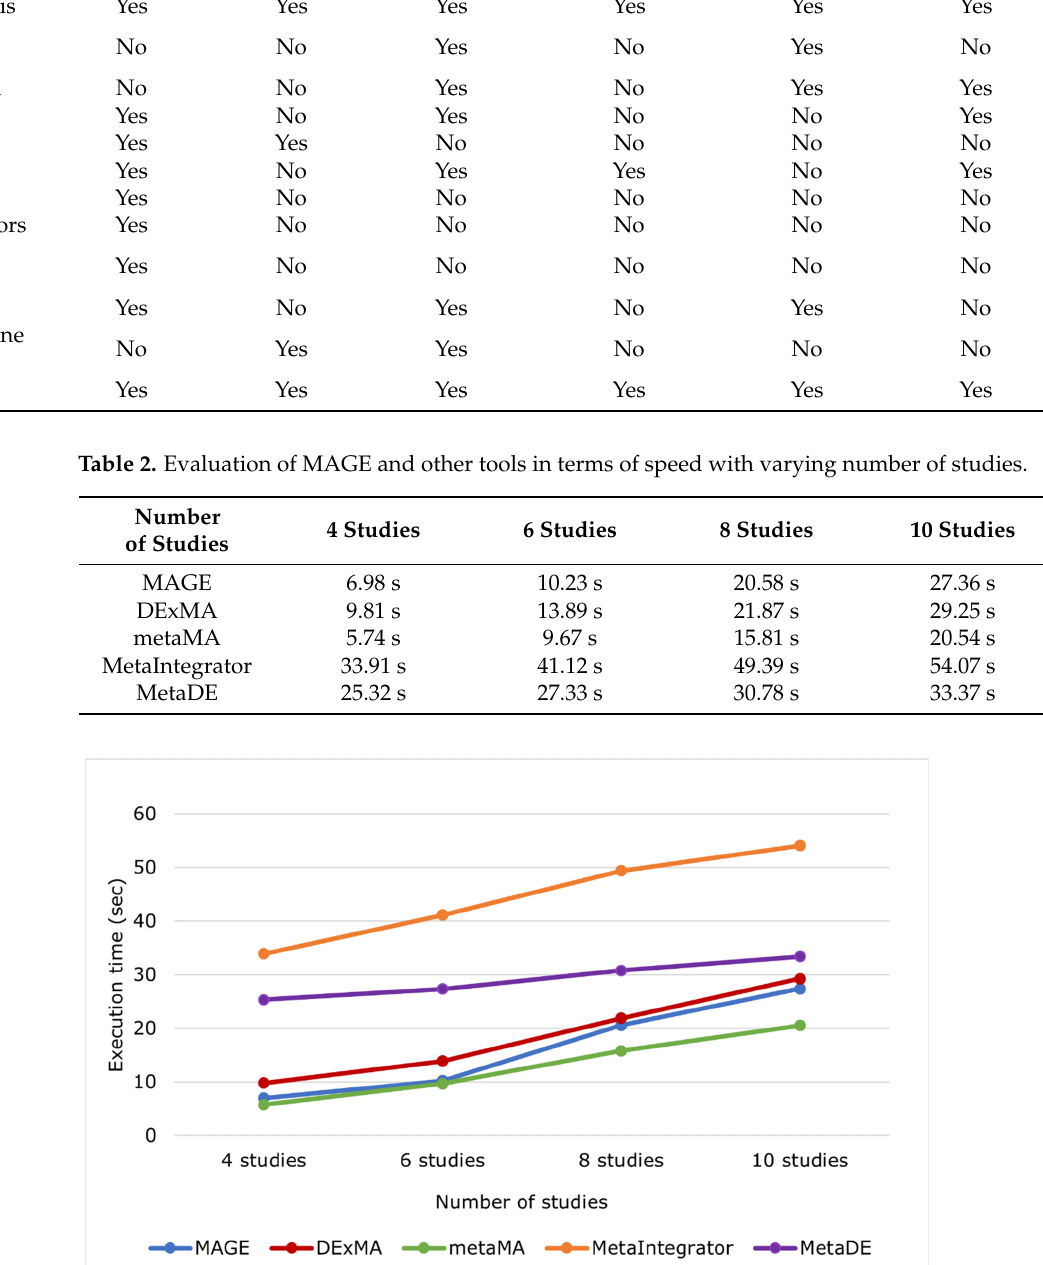
Figure 4. Run-time comparison of MAGE and other tools using different number of studies.